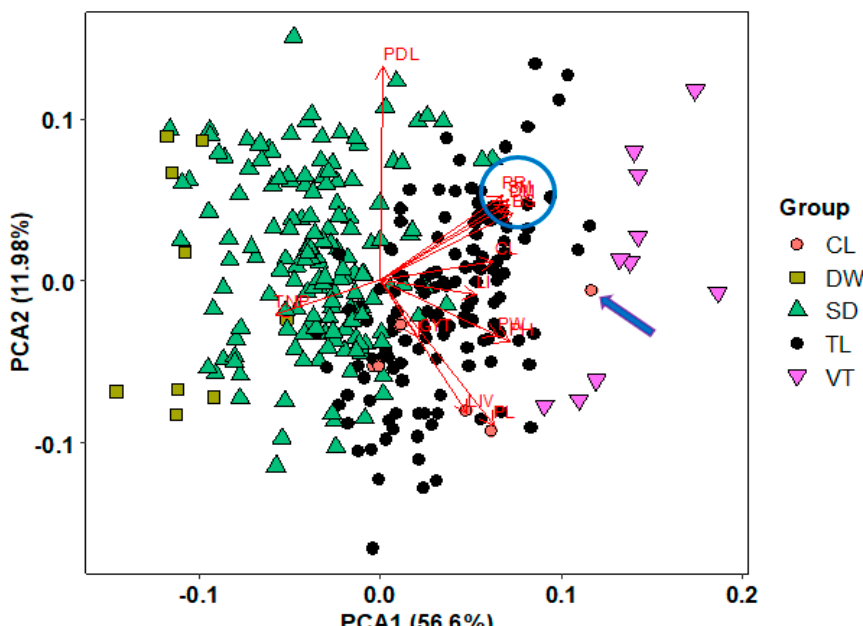
Figure 7. Principal component analysis results for the 13 agro-morphological and biomechanical traits of the 320 teff genotypes. The length of vectors indicates the loading of each trait and the angle between vectors indicates the relationship among the traits: number of tillers per plant (TNP), peduncle length (PDL), panicle length (PL), lodging score (LIV), plant height (PH), panicle weight (PW), culm length (CL), second basal internode diameter (DM), grain yield (GYT), pushing resistance (PR), section modulus (SM), second moment of area (MI), base failure moment (BS), and lodging index (LI). The Group refers to the plant height-based classification of the genotypes as described in Figure 3.